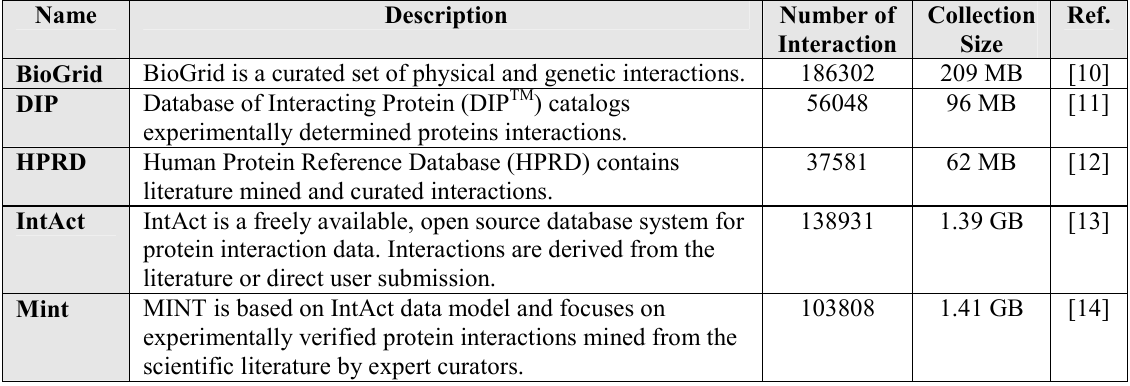
Table 1: Description of Protein Interaction Data